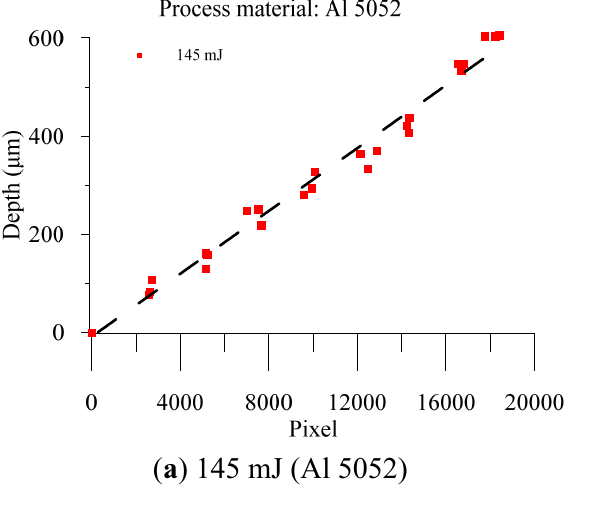
Figure 11. Relation between depth of laser-drilled hole and pixels of plasma region, at radiation energy of ( a ) 145 mJ (Al 5052); ( b ) 175 mJ (Al 5052); ( c ) 200 mJ (Al 5052); ( d ) 145 mJ (SS 420); ( e ) 175 mJ (SS 420); and ( d ) 200 mJ (SS